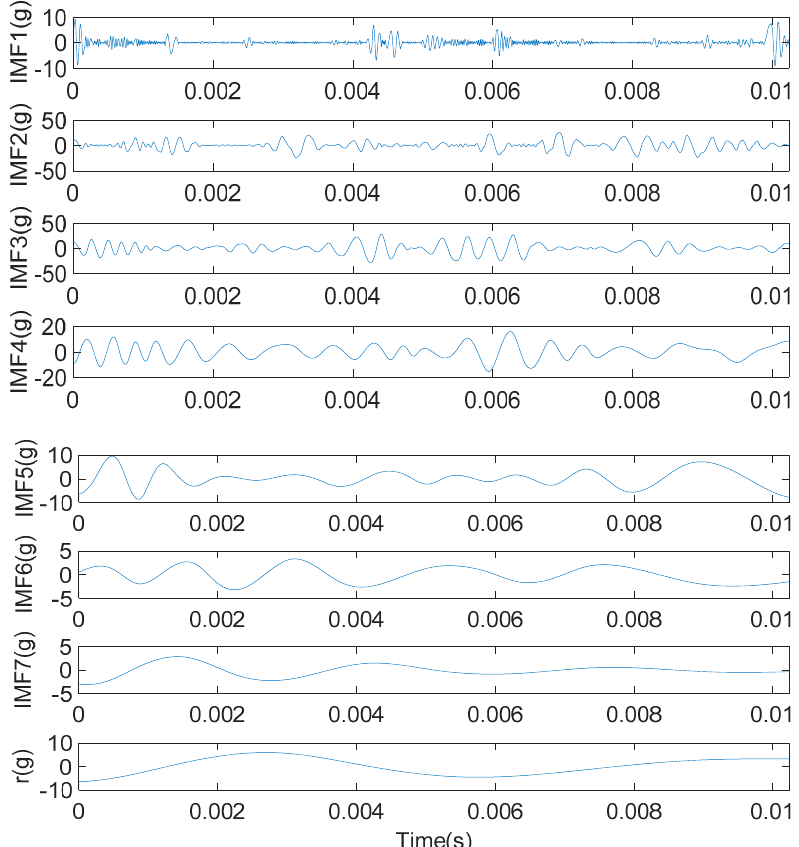
Figure 16. IMF component of the engine block vibration signal under a weak knock condition at 5200 rpm.